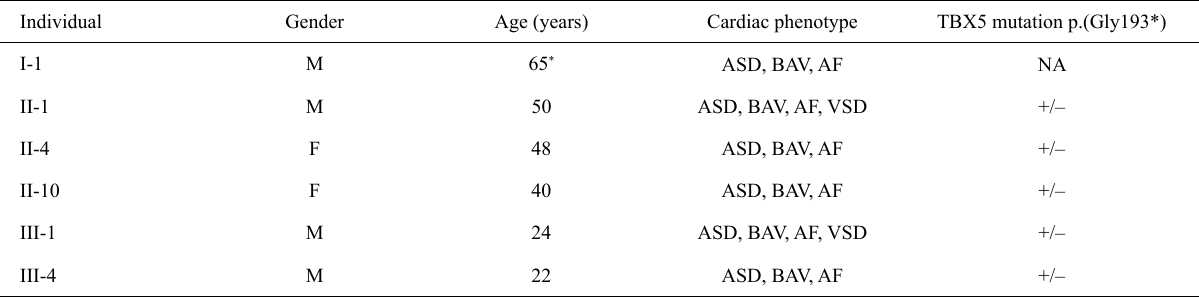
Table 2 – Phenotypic features and TBX5 mutation status of the family members with congenital heart defect and atrial fibrillation as well as bicuspid aortic